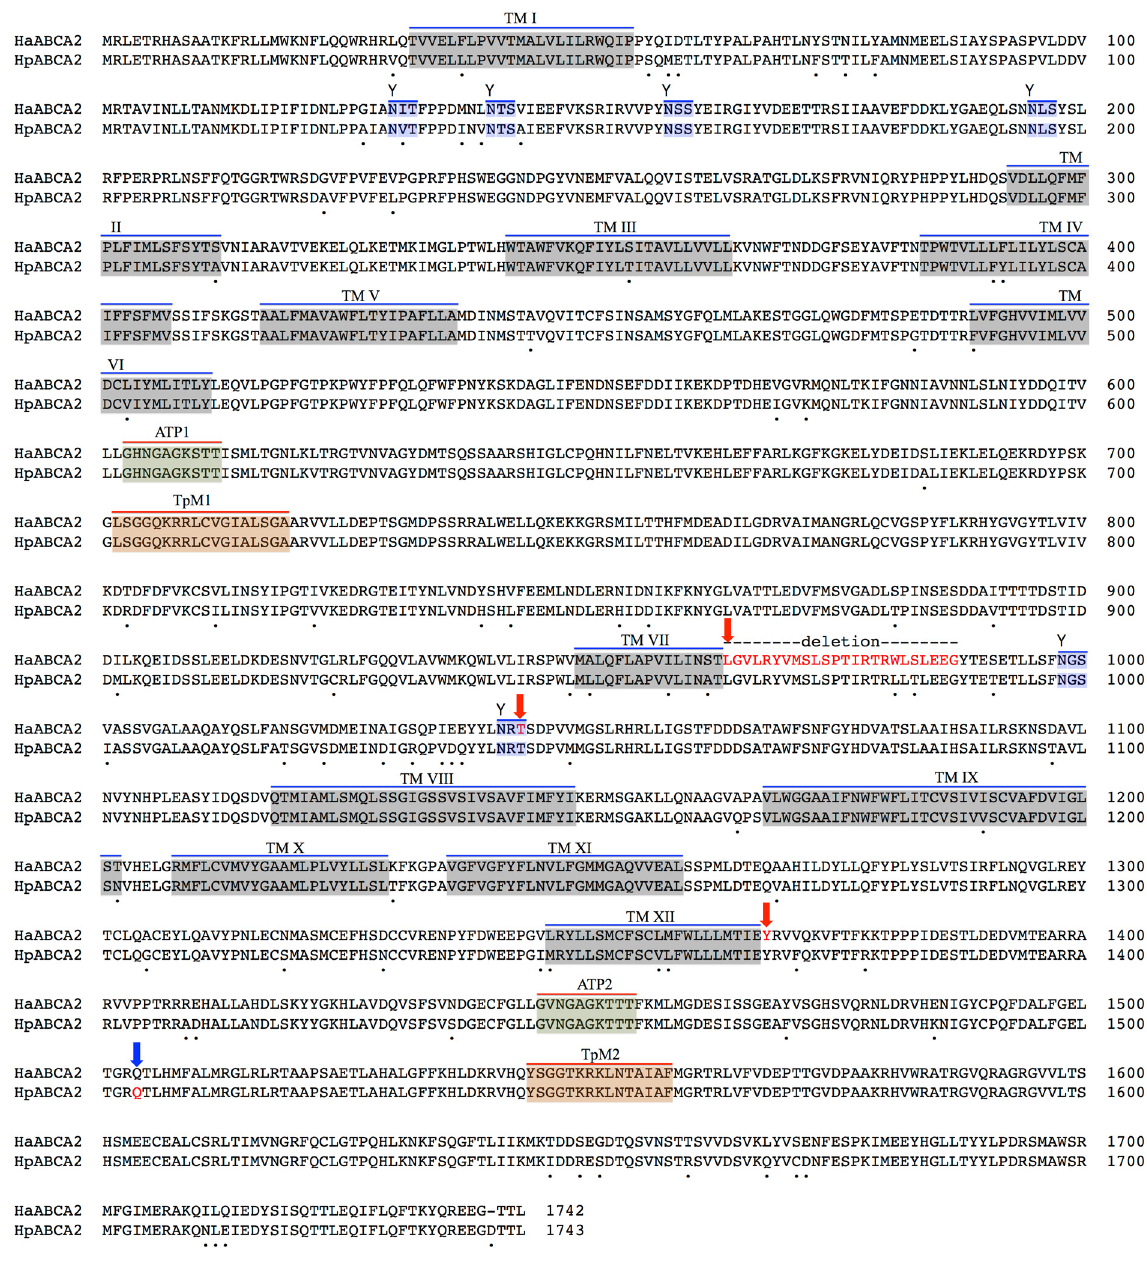
Fig 3. Predicted protein sequence of HaABC2. Feature predictions include 12 transmembrane helices (TM I to XII), two ATP-binding domains ATP1 and ATP2, two transporter motifs TpM1 and TpM2, and predicted glycosylation sites (highlighted in blue, and indicated by ‘ Y ’ ). Amino acid differences between H . armigera and H . punctigera are indicated by ‘ . ’ mutation sites are indicated by red and blue arrows for H . armigera and H . punctigera respectively — Ha2Ab- R01 (amino acid position 964); Ha2Ab-R02 (amino acid position 1,043); Ha2Ab-R03 (amino acid position 1,368); and Hp2Ab-R04 (amino acid position